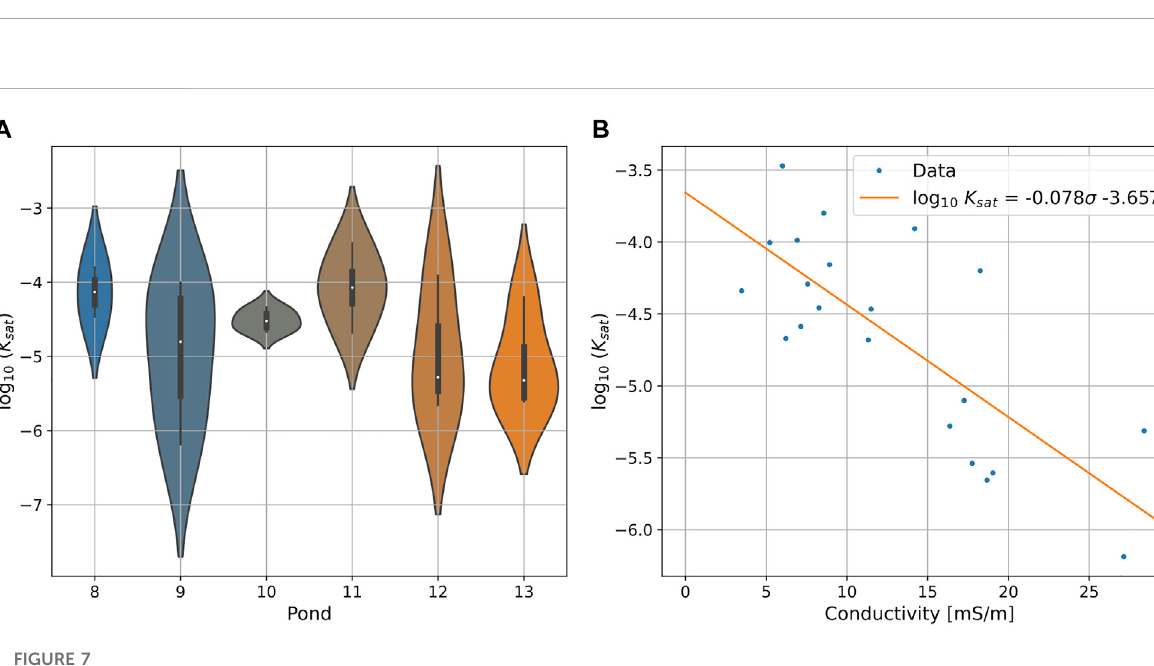
FIGURE 6 Inverted resistivity models. (A) 3D view of Ponds 8 to 13., (B) horizontal slice at 0.1 m depth, (C) horizontal slice at 1.0 m depth. (B) and (C) capture the lateral and vertical soil heterogeneity and identify bounds of the fi nes dominated, low hydraulic conductivity (blue) and coarser, high hydraulic conductivity (yellow-red) soils.